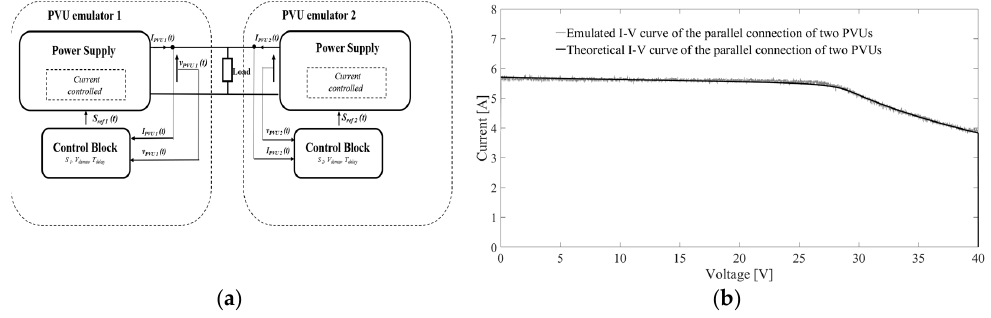
Figure 15. Performance of parallel connection of two Boost PVU emulators: ( a ) block diagram of system under test; ( b ) S 1 = 400 W / m 2 , S 2 = 300 W / m 2 , T = 57.5 ◦ C, and V dsmax = 40 V.